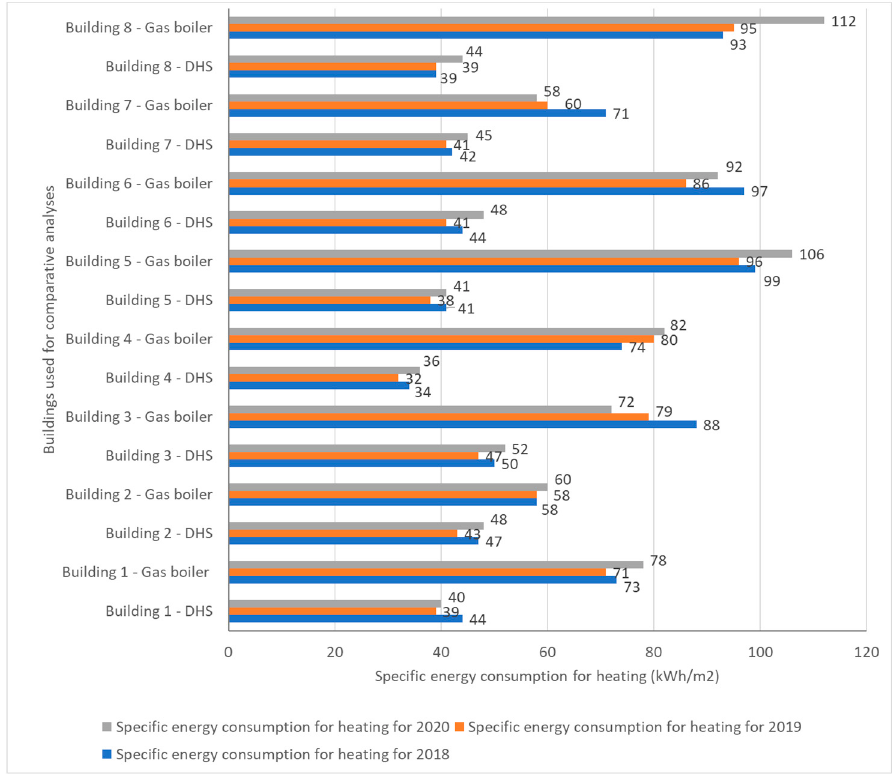
Figure 8. Comparative representation of specific energy consumptions for heating in 2018–2020 for both groups of buildings .